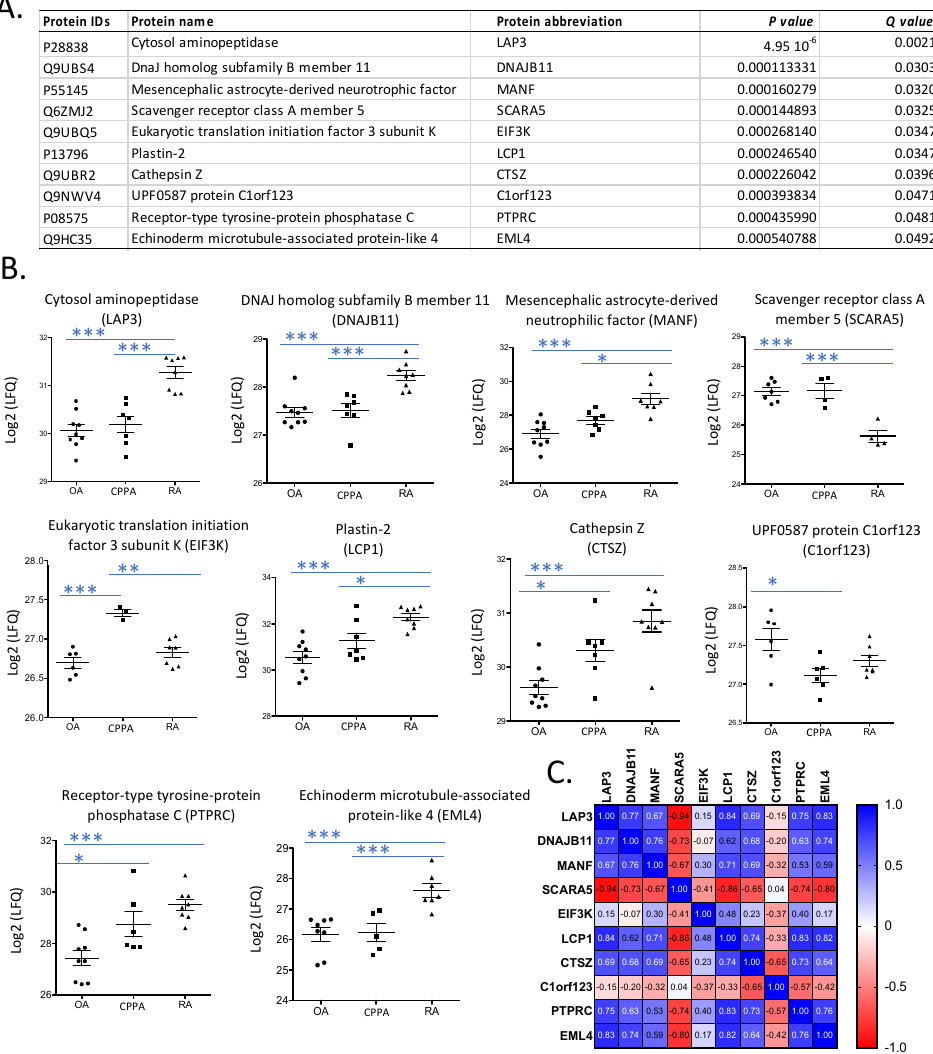
Figure 1. Proteomic analysis by mass spectrometry of synovial membrane from OA, CPPA and RA patients. ( A ) Protein expressions significantly modulated in OA, CPPA or RA synovial biopsies using the multiple sample test with 1400 permutation-based FDR for statistical analysis. ( B ) Representation of protein expressions obtained by mass spectrometry (Log2 (LFQ)) for the three pathologies. One- way ANOVA test with a post hoc test of Tukey was applied on logarithmic values: * P < 0.05, ** P < 0.01 and *** P < 0.001. ( C ) Correlation coefficients between the 10 highlighted biomarkers calculated according to the parametric Pearson test. OA, osteoarthritis; CPPA, chronic